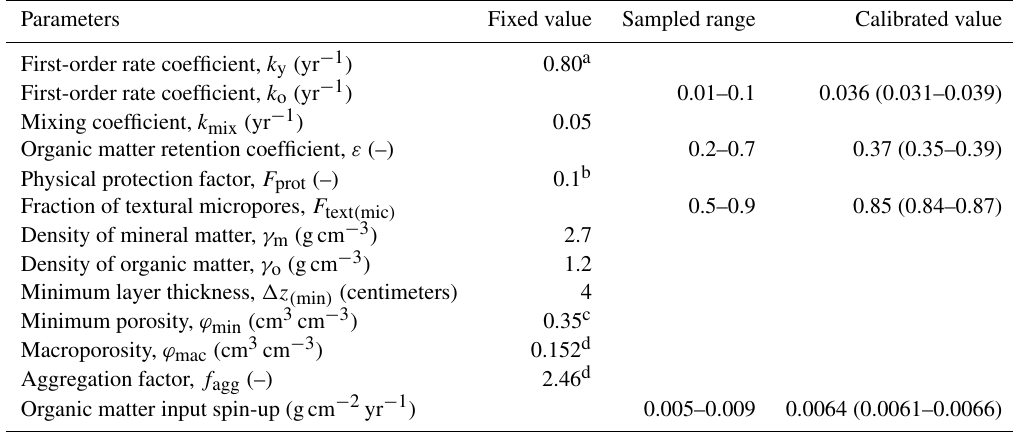
Table 4. Fixed parameters and range of parameter values included in the calibration, and the final parameter estimates after calibration. The range of the best fit parameter values for the calibration runs with goal function values no more than 5% larger than the value for the best simulation ( n = 85) is given within